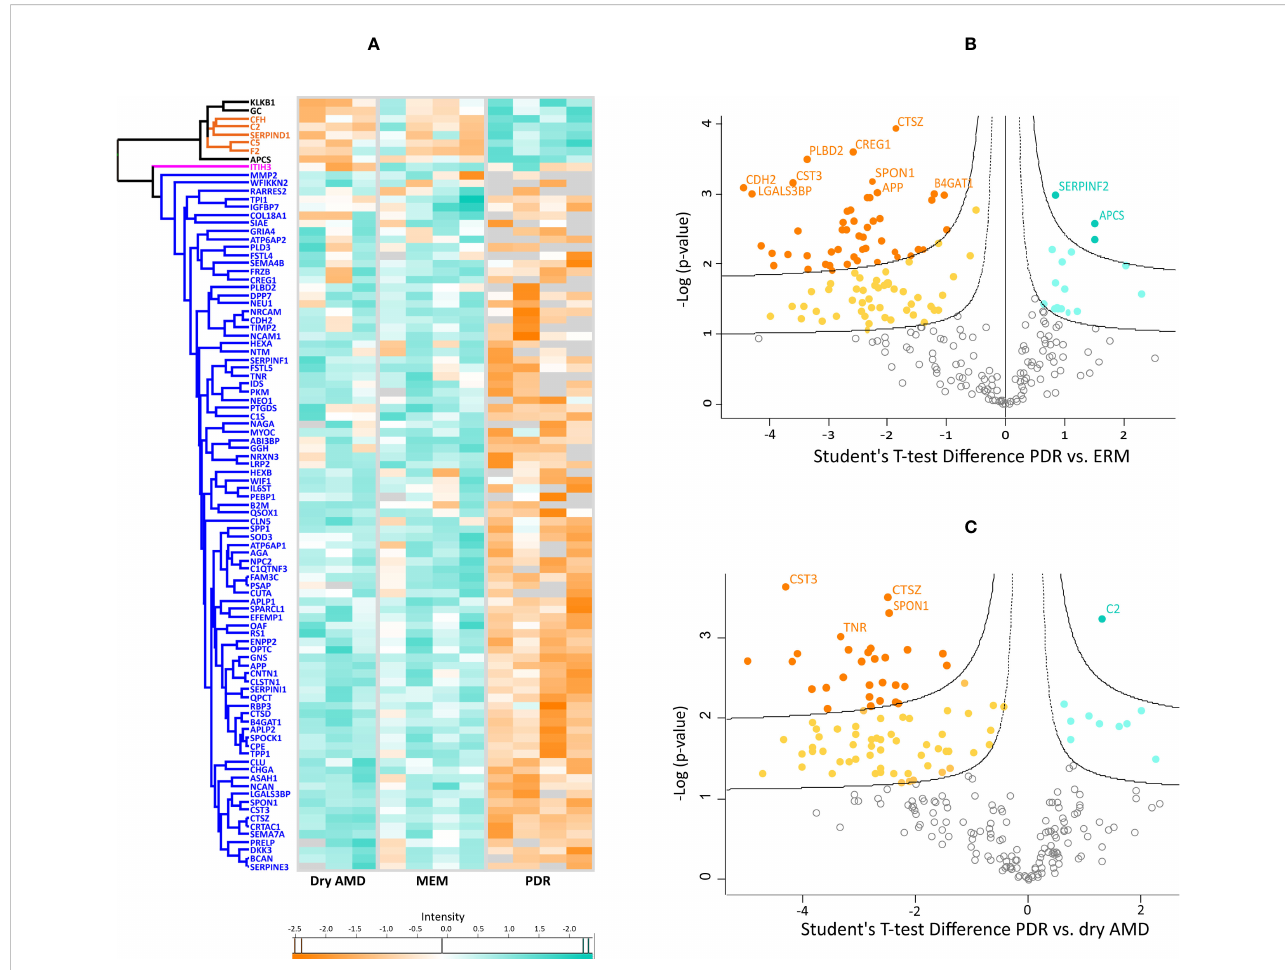
FIGURE 1 (A) Heatmap representing the intensities normalized to log base 2 and analyzed by hierarchical clustering of 96 proteins found differentially expressed among the three disease groups in posthoc tests. Hawaii plots display the proteins found up-regulated (blue-green) and down-regulated (orange) in proliferative diabetic retinopathy (PDR) compared to patients with (B) epiretinal membranes (ERM) and with (C) dry age-related macular degeneration (dry